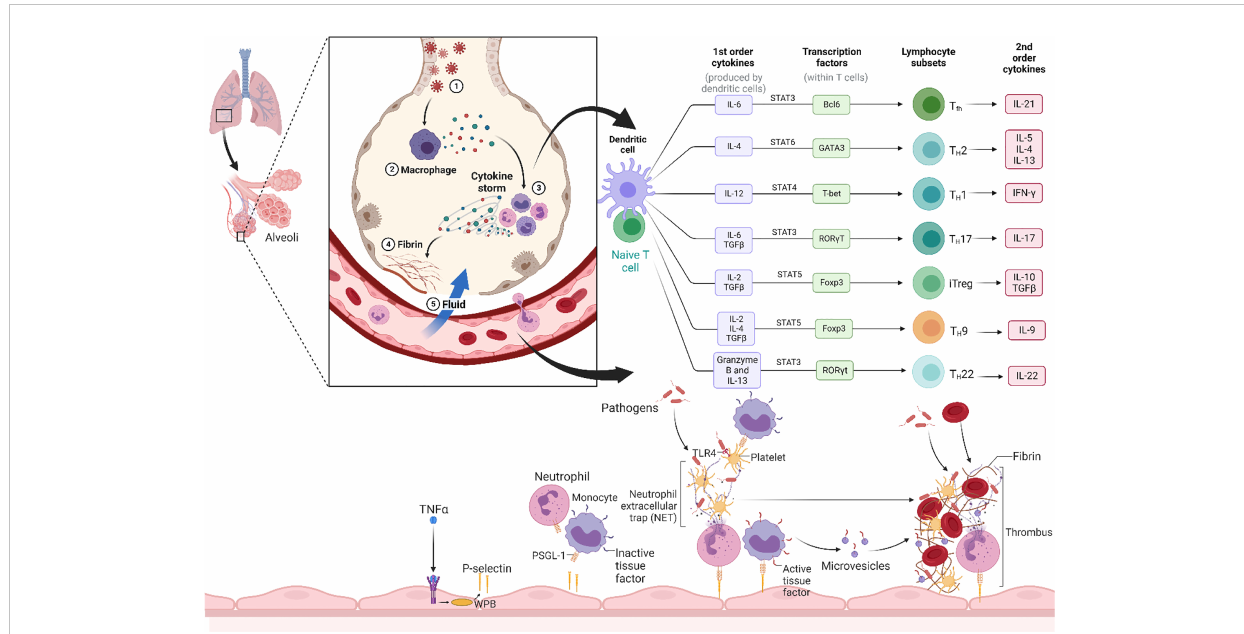
FIGURE 1 Overall mechanism of the cytokine storm. The cytokine storm is caused by SARS-CoV-2, which causes severe cytokine/chemokine reactions (Release of fi rst order and second order cytokine like IL-1, IL-2, IL-4, IL-6, IL-7, IL-10, IL-12, IL-13, IL-17, M-CSF, G-CSF, GM-CSF, IP-10, IFN- g , MCP-1, MIP 1- a , hepatocyte growth factor (HGF), TNF- a , and vascular endothelial growth factor (VEGF)) in certain people with the disease. Cytokine storm induces ARDS, also known as multiple-organ impairment that also leads to physiological deterioration and fatality. (Created with